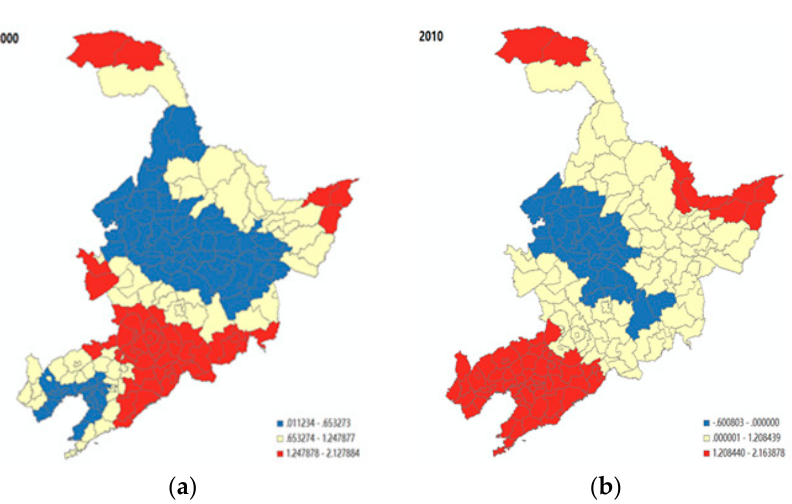
Figure 6. The spatial variability of the effect of industrial structure on population ageing. ( a ) Year 2000; ( b ) Year 2010.